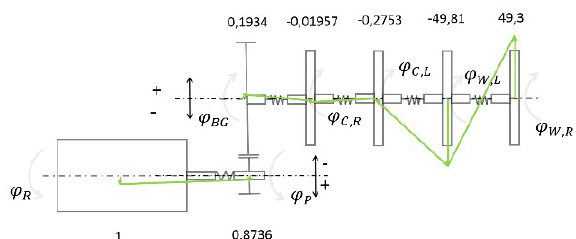
Figure 12. Third natural mode of torsion oscilla- tions [3].